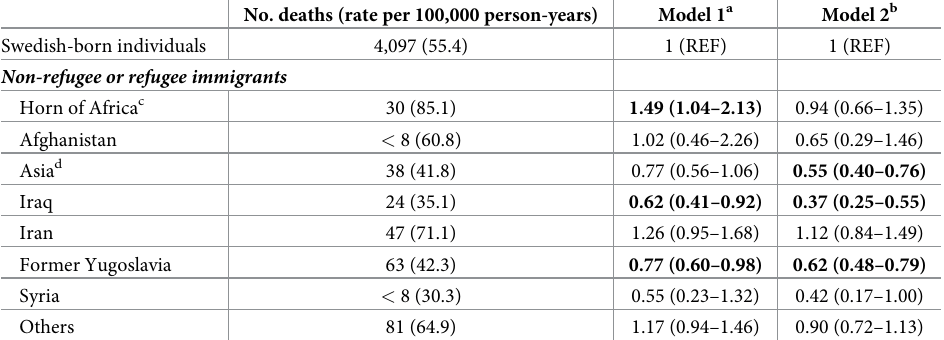
Table 5. Risk of all-cause mortality by refugee status and country of birth. Individuals aged 19–25 years old resid- ing in Sweden in 2004. Hazard ratios (HRs) with 95% confidence intervals